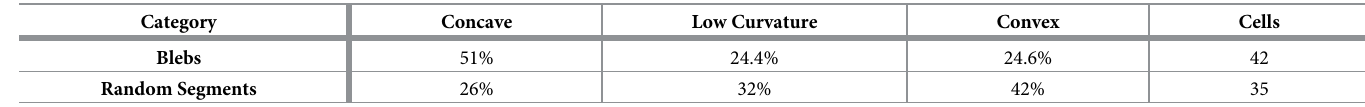
Table 1. Bleb distribution: Wild type under 0.7%